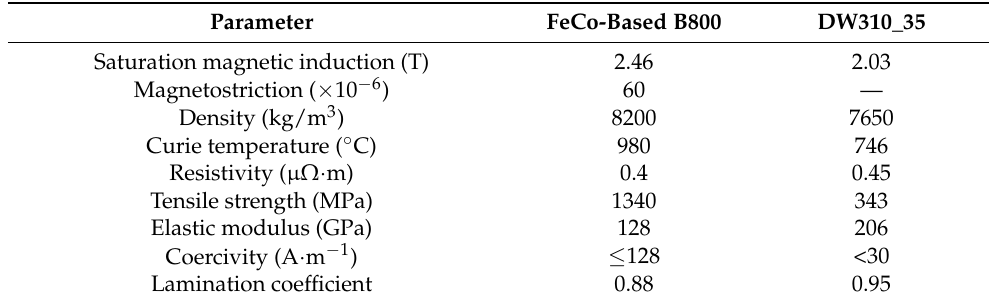
Table 8. Stator material performance